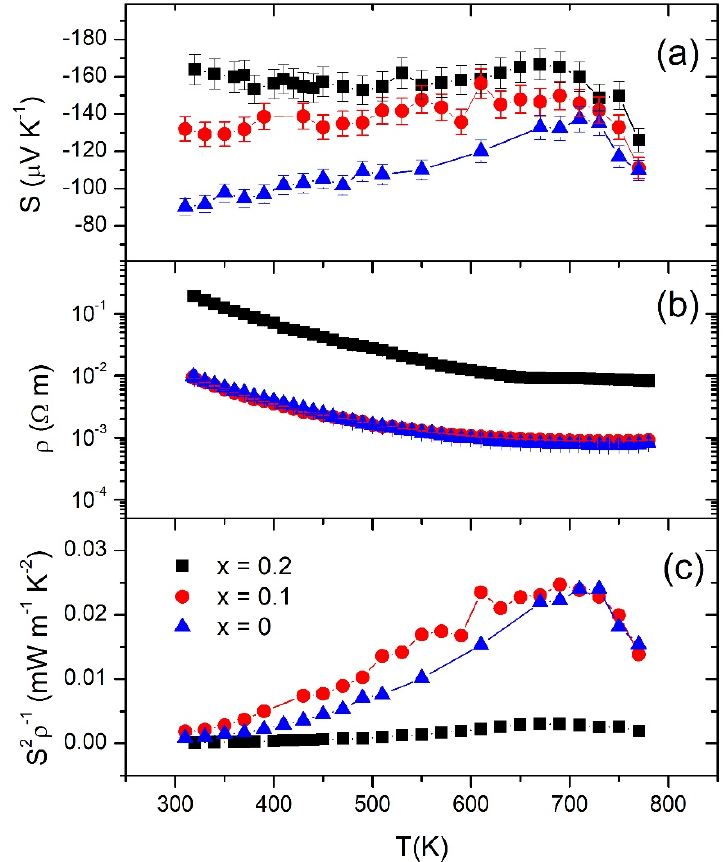
Figure 5. Temperature dependence of ( a ) the Seebeck coefficient (S), ( b ) electrical resistivity (ρ), and ( c ) power factor (S 2 ρ −1 ) of Sr 1-x Ti 0.9 Nb 0.1 O 3-δ (x = 0, 0.1, 0.2).